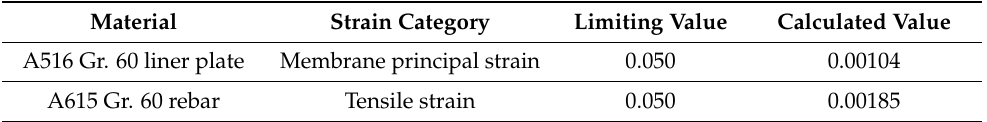
Table 7. Ductile failure strain